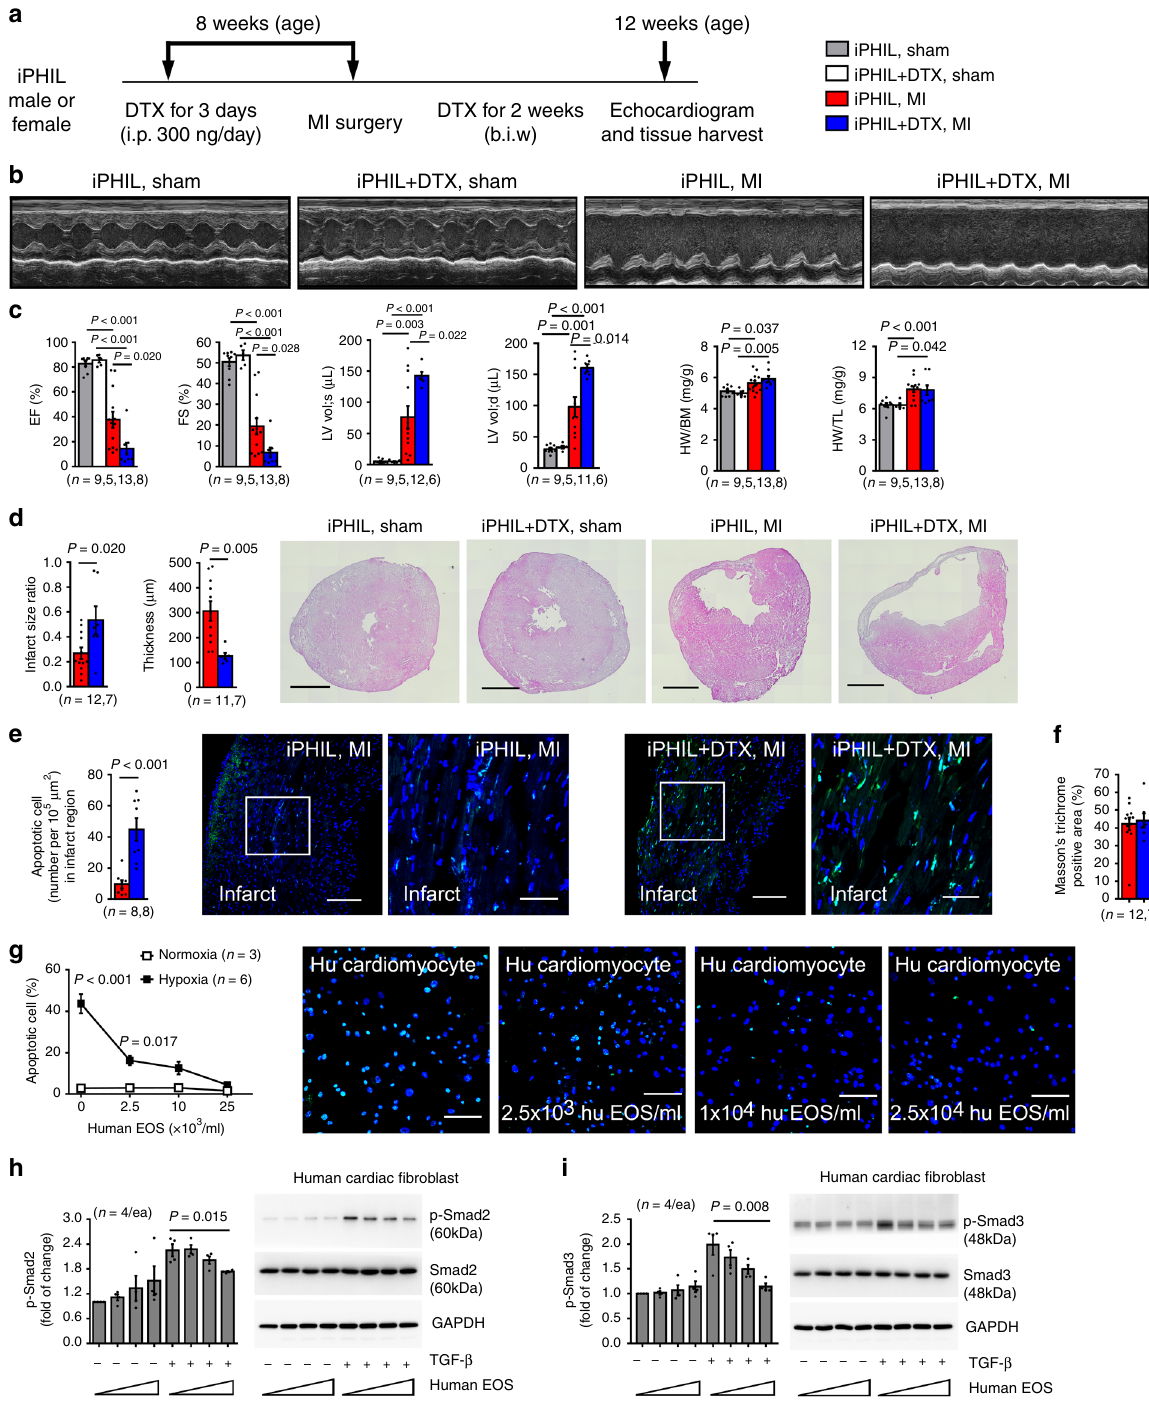
Fig. 6 DTX-induced EOS depletion exacerbates cardiac functions post-MI. a Mouse surgery and treatment strategy. b Representative LV M-mode echocardiography images at 1-month post-MI from different groups of mice. c . EF, FS, LV Vol;d, LV Vol;s, HW/BW, and HW/TL in different groups of mice. d – f Infarct size ratio and thickness ( d ), infarct TUNEL-positive apoptotic cells ( e ), and infarct region Masson ’ s trichrome-positive areas ( f ) in hearts from different groups of mice as indicated. Representative H&E staining (Scale: 1500 µ m) and TUNEL staining (Scale: 100 µ m, inset: 30 µ m) images are shown to the right. g TUNEL staining of human cardiomyocytes treated with different doses of human EOS lysates (equivalent to 2.5 × 10 3 , 1 × 10 4 , 2.5 × 10 4 EOS/ ml) under hypoxia and normoxia conditions for 36 hrs. Representative images are shown to the right. Scale: 30 µ m. h , i Immunoblot detection of p-Smad2/ 3, total Smad2/3 and GAPDH from human cardiac fi broblasts treated with and without different doses of human EOS lysate (equivalent to 1 × 10 4 , 2 × 10 4 , 4 × 10 4 EOS/ml) and TGF- β (10 ng/ml) for 30 min. Data are mean ± SEM. The numbers of mice ( c – f ), the numbers of independent experiments ( g – i ), and P values are indicated, one-way ANOVA test ( c , h , i ) and non-parametric Mann-Whitney U test ( d – g